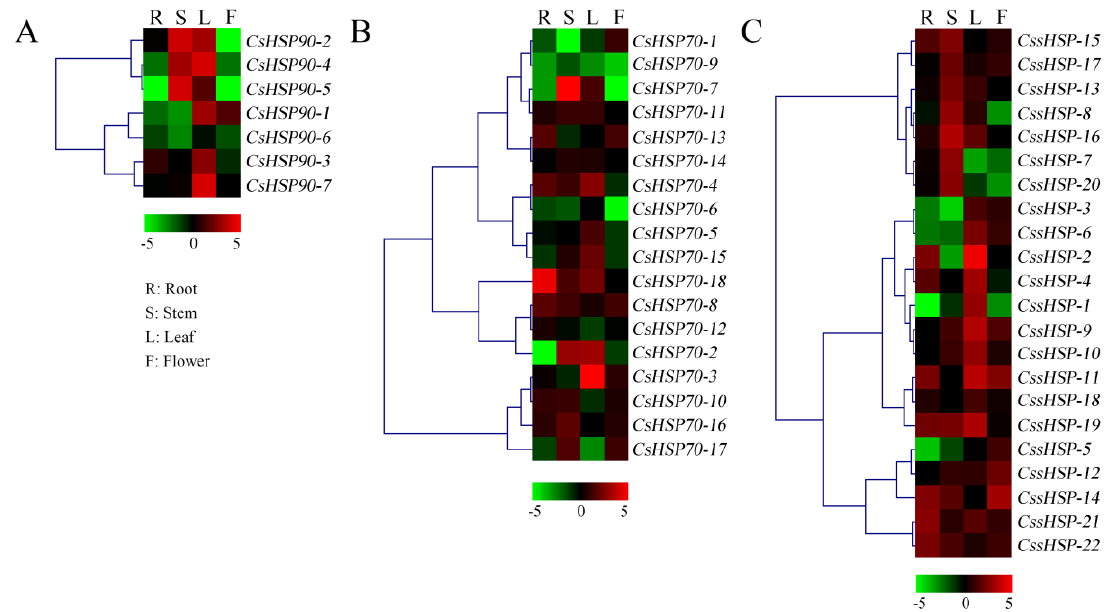
Figure 6. Expression patterns of CsHSP90 ( A ), CsHSP70 ( B ), and CssHSP ( C ) genes in different tissues of tea plant. R indicates root; S, stem; L, leaf; F, flower. The heatmap was generated by MeV software (TIGR, Rockville, MD, USA) using the CsHSP genes’ expression data, and normalized log 2 transformed values were used with hierarchical clustering. The red and green colors indicate higher or lower transcript abundances than those of the relevant control, respectively.